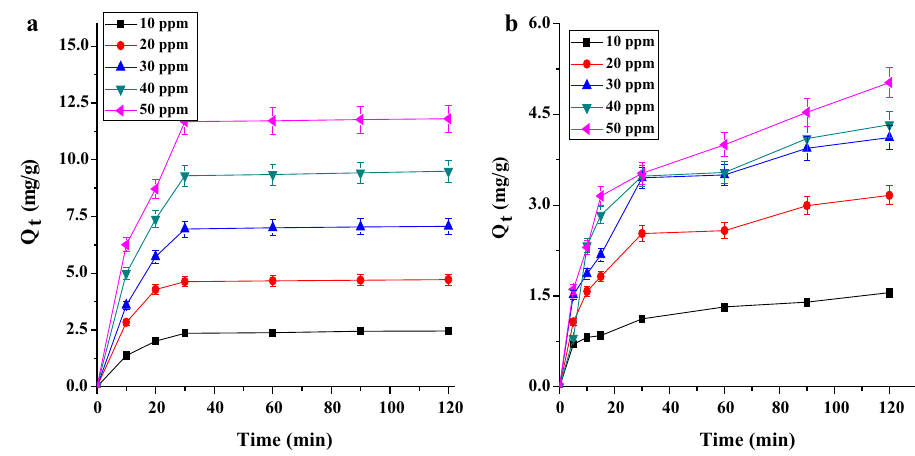
Fig. 5 Effect of initial concen- trations and contact time on the removal a MB and b